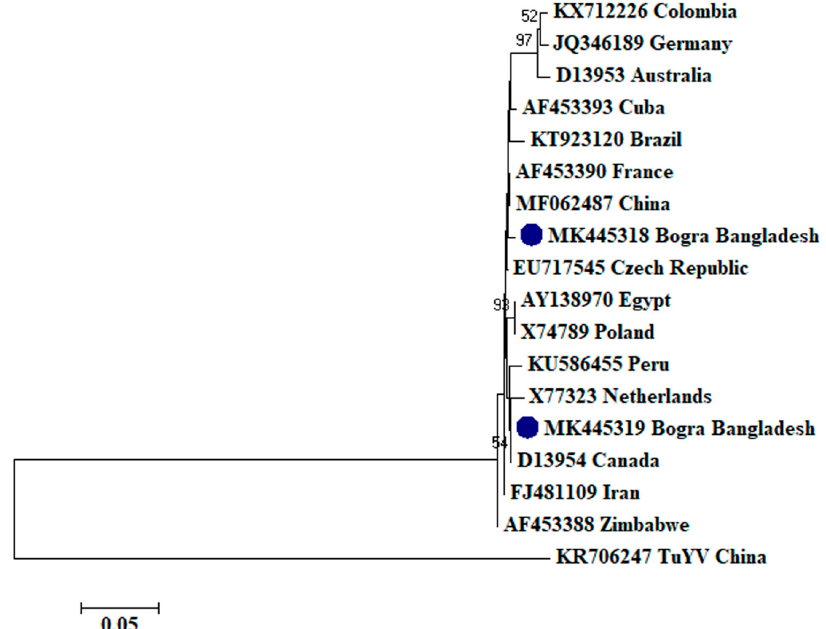
Figure 1. Phylogenetic analysis of Potato leafroll virus detected from Bangladesh based on the coat protein gene sequences (nt) of different selected isolates from the NCBI database. The phylogenetic tree was generated by MEGA7 using neighbor-joining method with 1000 bootstrap replicates, and only values >50% are shown at the nodes. An isolate of Turnip yellows virus (TuYV) from China was used as an outgroup.